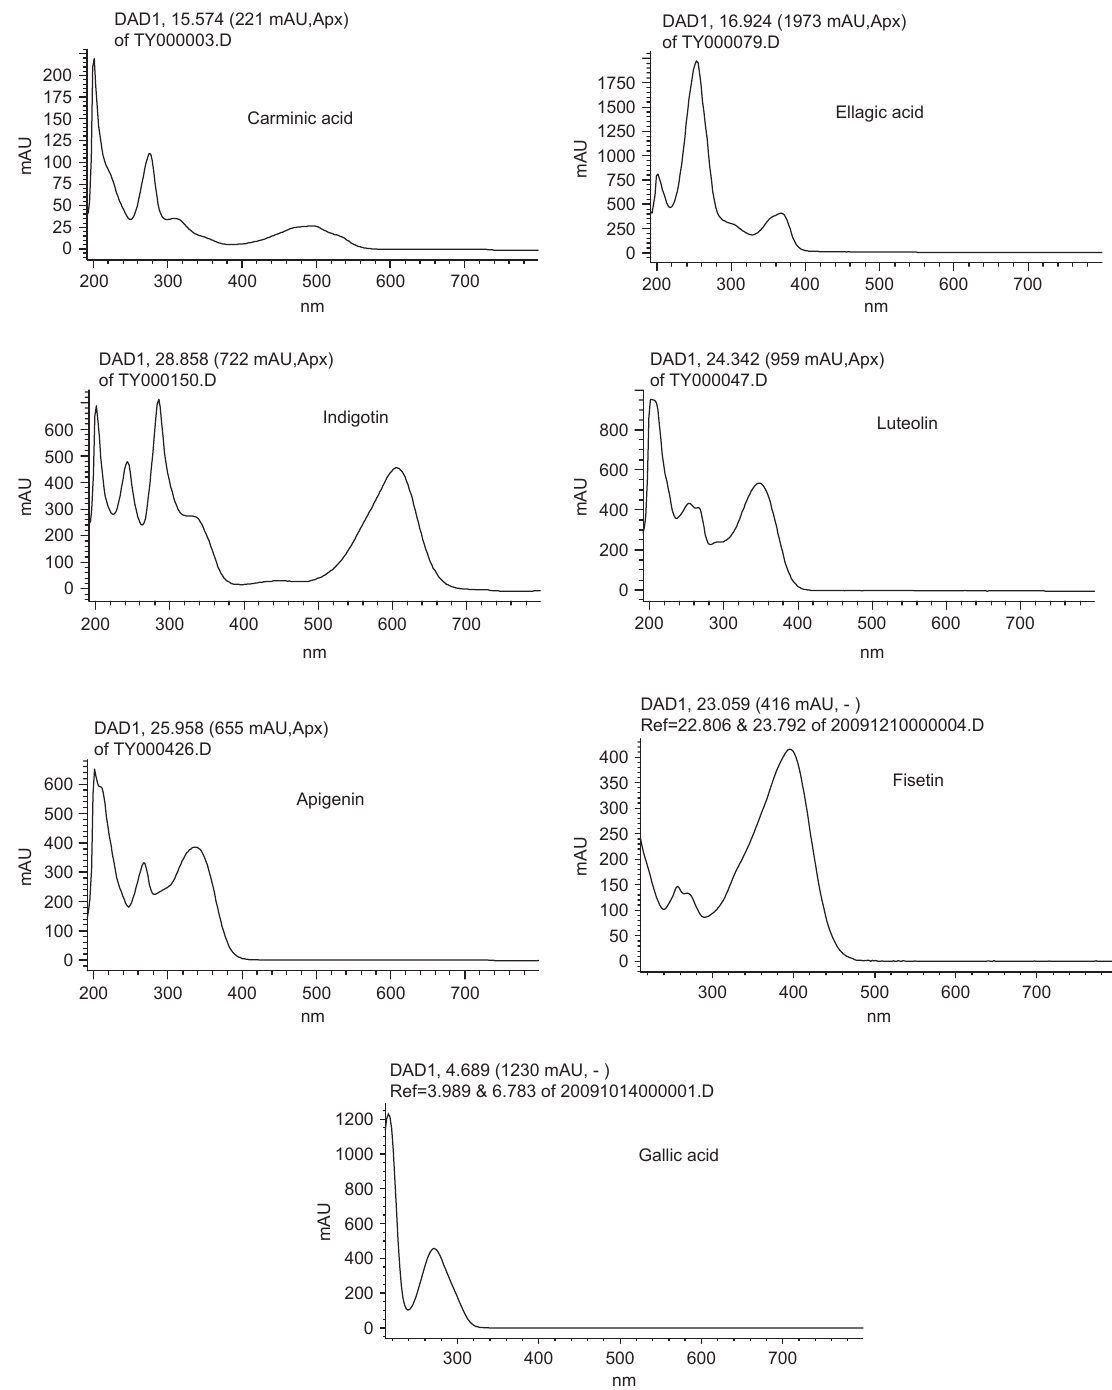
Figure 2 UV-visible absorption spectra of carminic acid, ellagic acid, indigotin, luteolin, apigenin, fi setin and gallic acid.